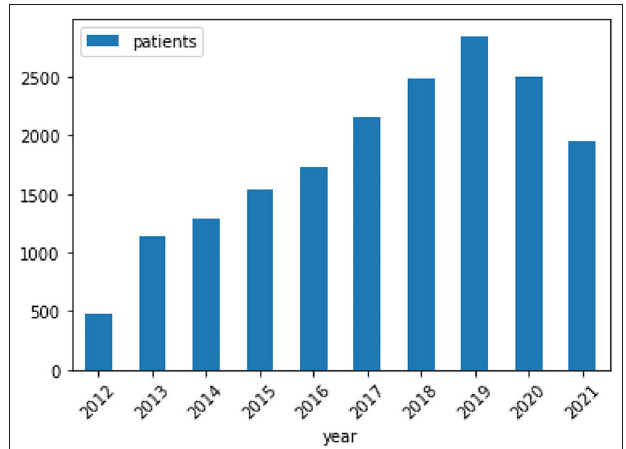
FIGURE 7 | Annual use of the software displayed per year for the number of patients assisted.